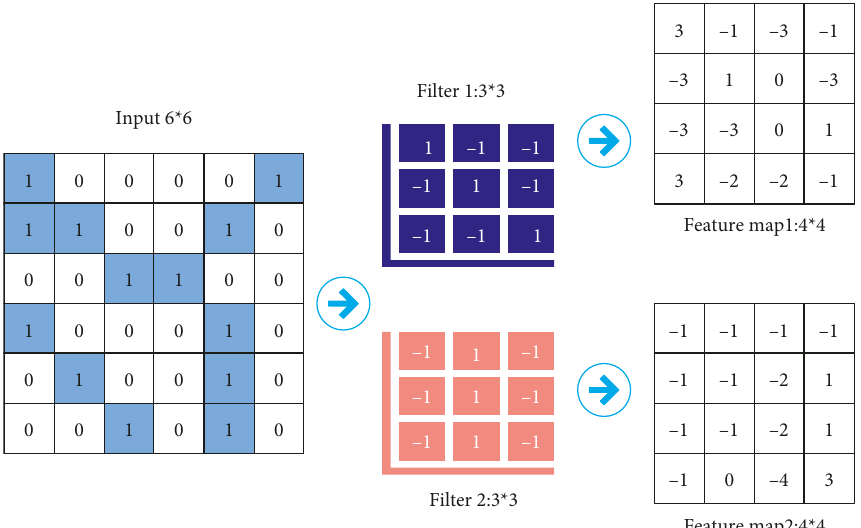
Figure 5: Example of the convolution process of the convolution